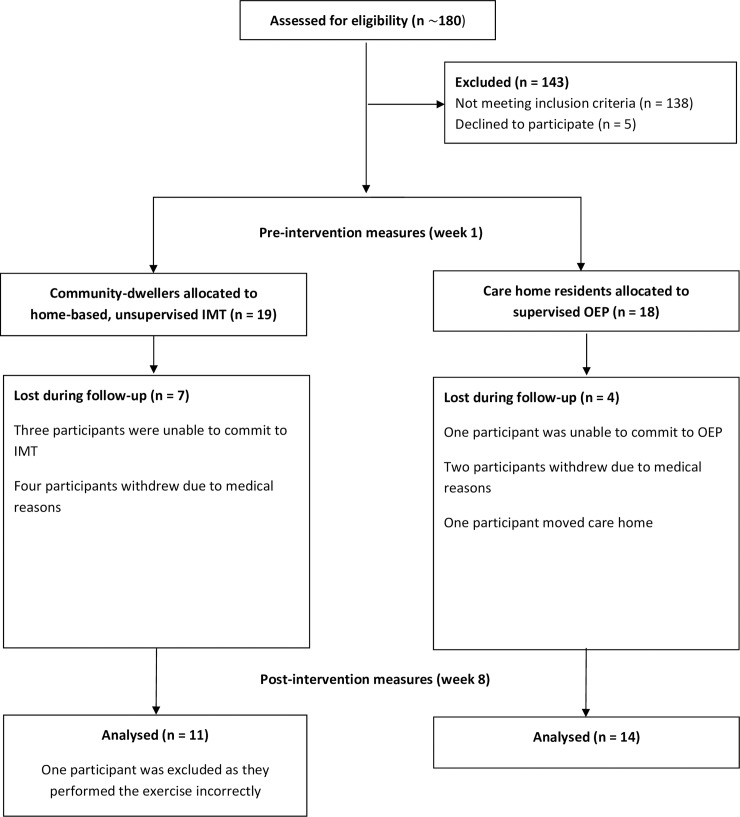
CONSORT flow diagram displaying participant pathways through the 8 week non-randomised comparison study.IMT = inspiratory muscle training, OEP = Otago exercise program.